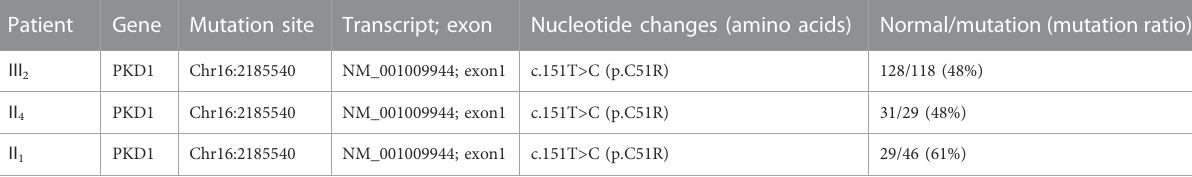
TABLE 2 MPCR + targeted region sequencing results of the case 1